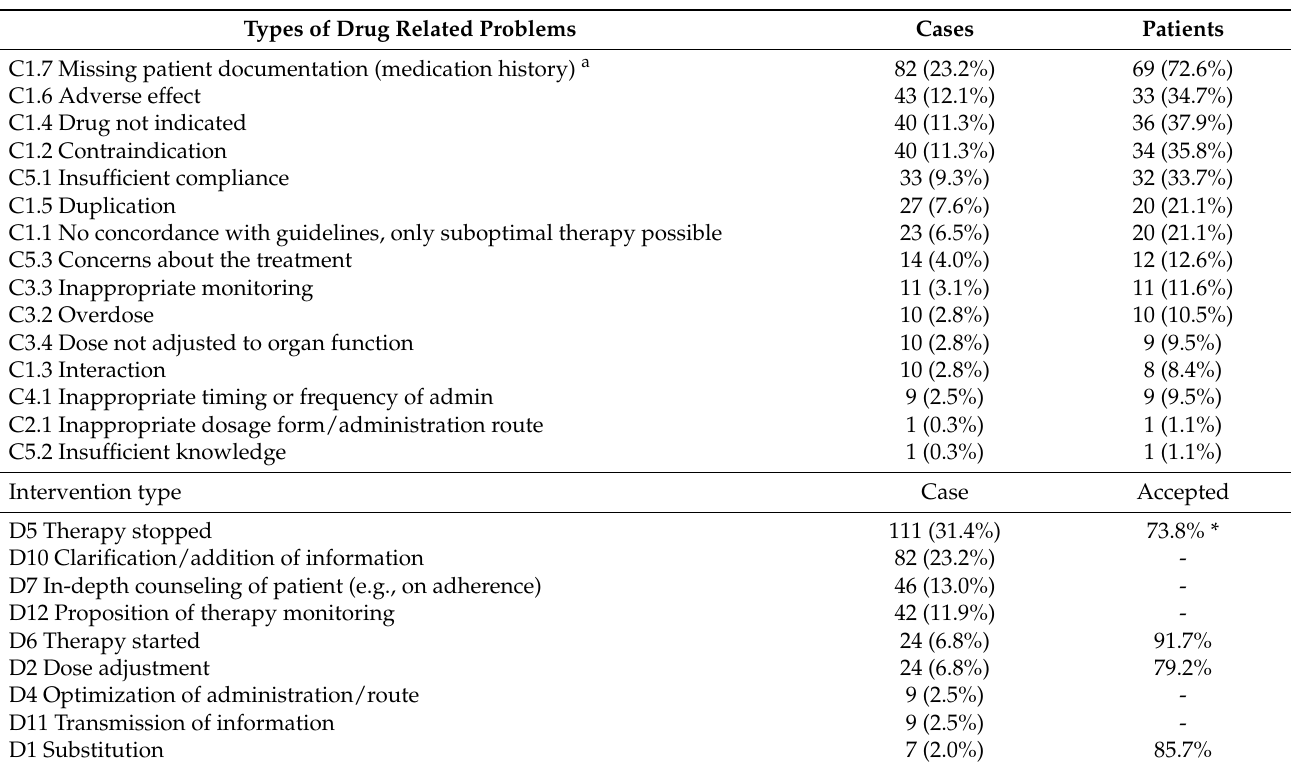
Table 3. Types of baseline drug-related problems and pharmacist